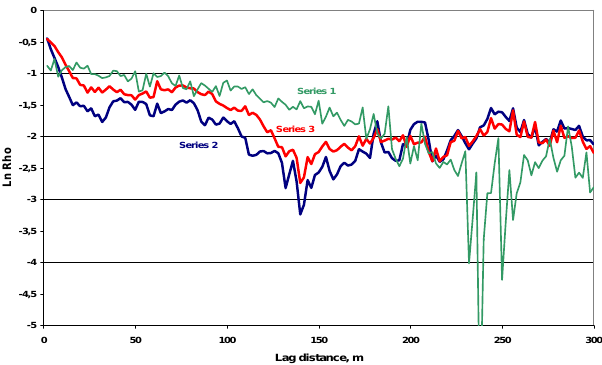
Fig. 16. Correlograms for three consecutive series of copper con- centration (ppm) values from Main KTB borehole. Series 2 (for depths between 2 and 4 km) and Series 3 (for depths between 4 and 5.54km) show similar autocorrelation functions that differ from au- tocorrelation function for Series 1 (for depths between 0.05km and